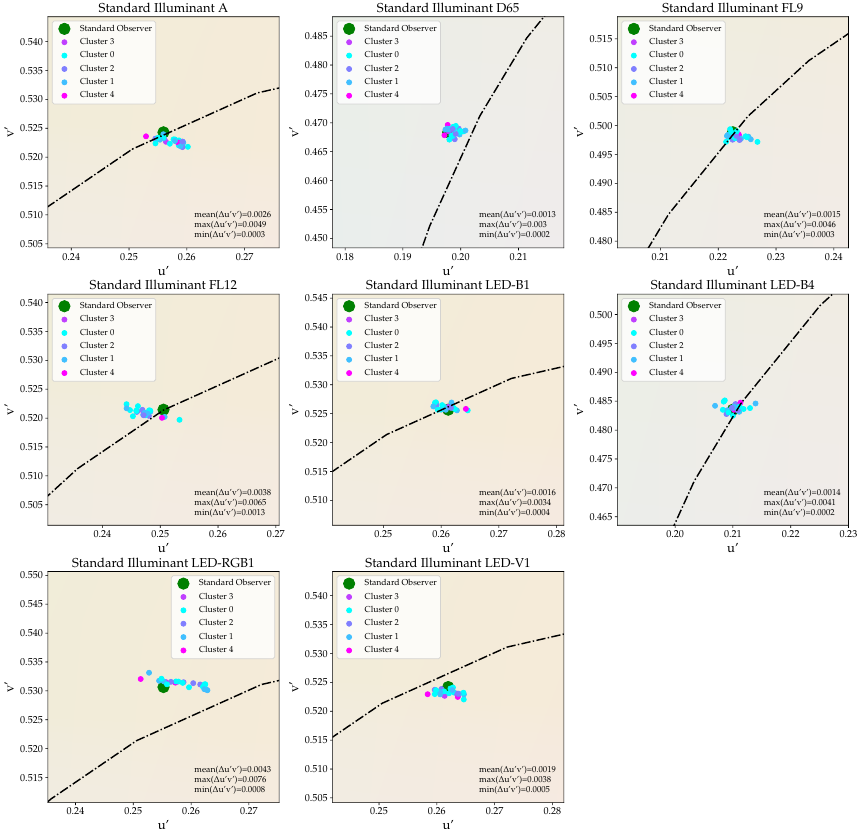
Figure 7. The results of a cluster-wise color correction of the 24 same-type true color sensors considered in this work after applying the proposed sensor binning